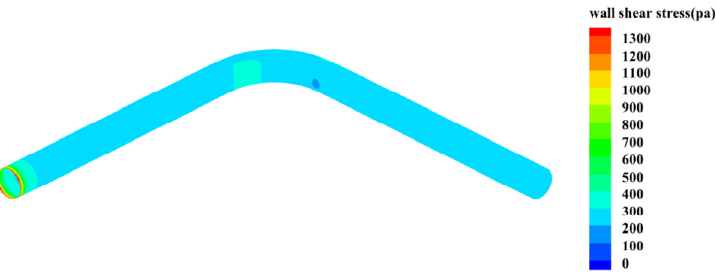
Figure 14. The distribution of the wall shear stress viewed from the inner bend in the 90° channel at the flow rate of 2.85 cm 3 /s, calculated using the new rheological model.